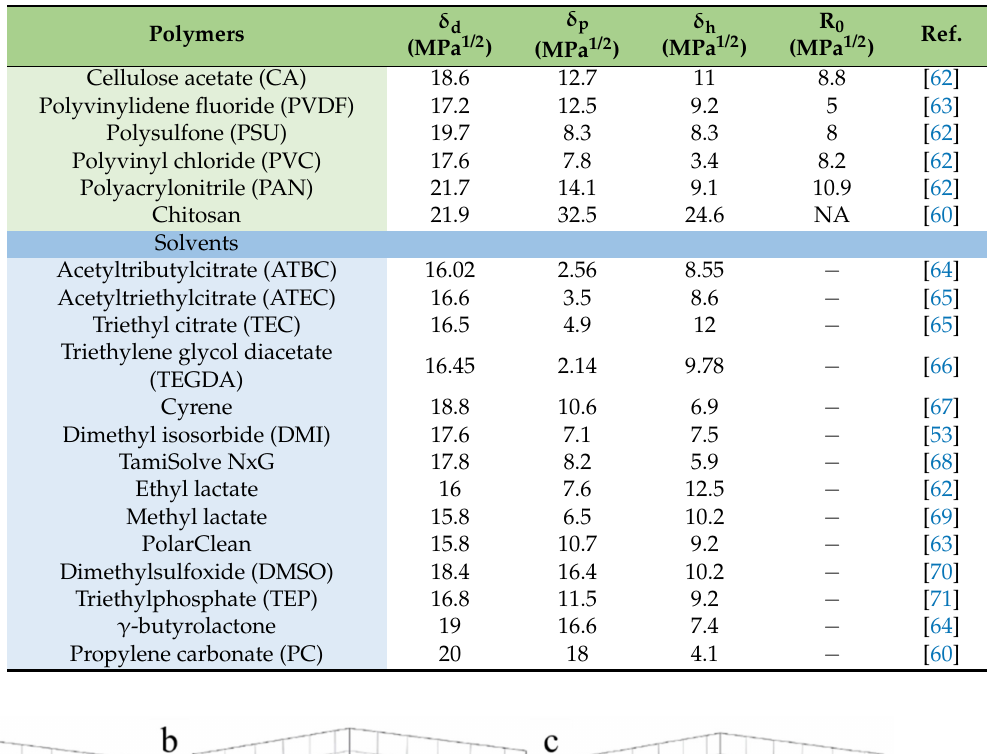
Table 2. HSP values of the polymers and the solvents, and the radius of interaction of the Hansen solubility sphere (R 0 ).